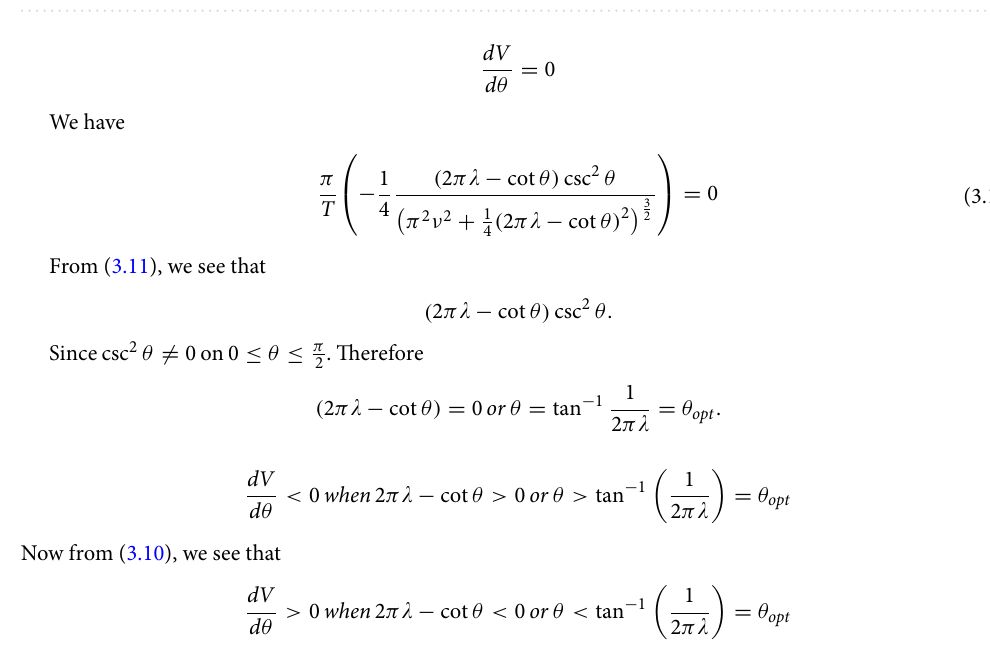
Figure 3. For the chirp u approximation of exponential chirps for N 1 ν 200 π for various values of =